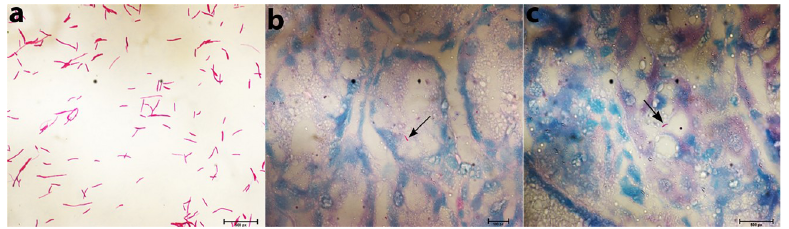
Fig 6. Identification of M . abscessus in gastric biopsy sections using Acid Fast (Ziehl-Neelsen) staining. (a) M . abscessus strains isolated from the gastric biopsies were subcultured, smeared on slides and were stained with Ziehl- Neelsen stain. (b&c) Ziehl-Neelsen staining of the two paraffin-fixed gastric tissue sections showed the presence of acid-fast bacilli ( M . abscessus ) at 100X